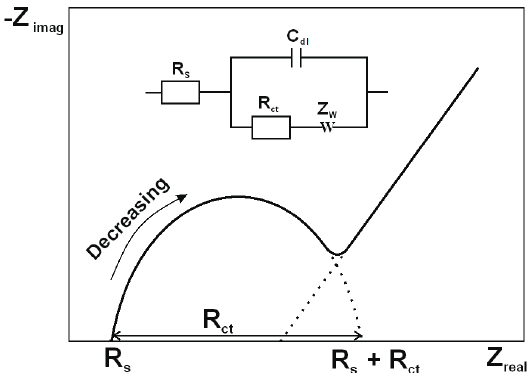
Figure 1. Nyquist plot resulting from electron impedance spectroscopy and Randles circuit was used for its fitting [23]. Symbols: R s —series resistance of solution, C dl —capacity of the double layer formed on the electrode surface, R ct —charge-transfer resistance between electrode and solution, Z w —Warburg impedance describing the diffusional resistance element.